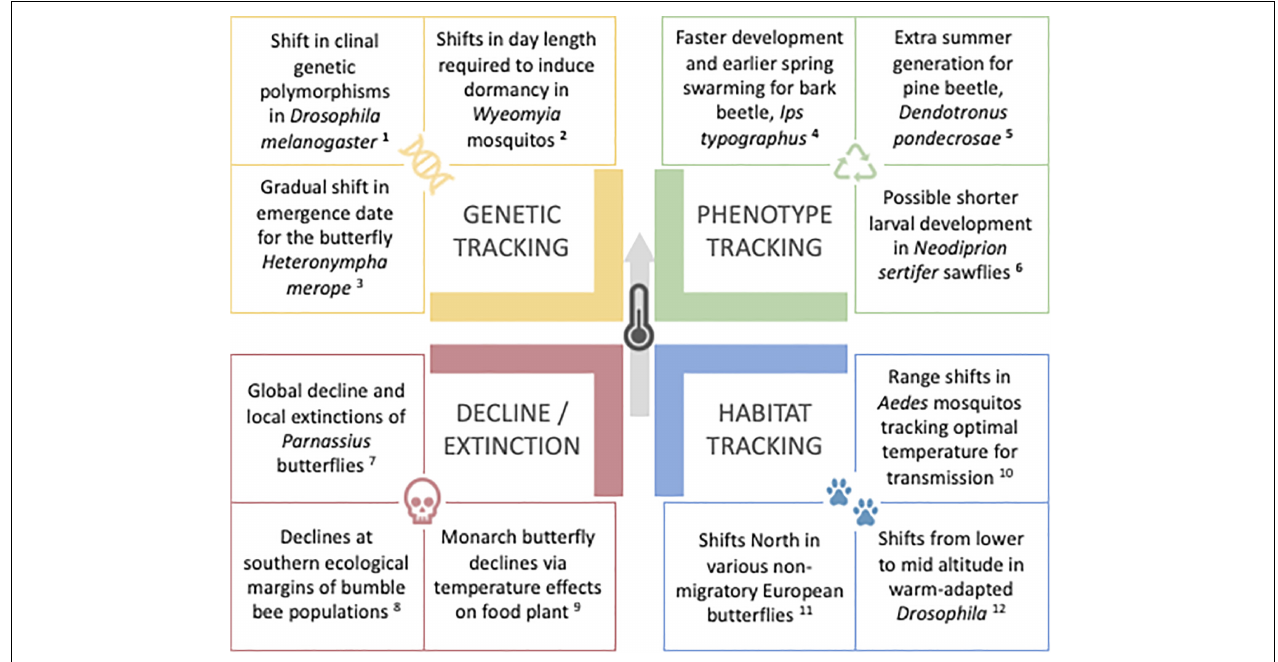
FIGURE 1 | Insect examples of responses to climate change. Populations facing warming temperatures that result from climate change can respond in different manners, including moving to new locations where temperature is closer to their optimum (blue), changing genetic composition as they adapt to new local conditions (yellow), expressing suitable temperature-induced phenotype without genetic change (green), or failing to adjust leading to decline and potential extinction (red). Examples from: 1 Umina et al., 2005; 2 Bradshaw and Holzapfel, 2001; 2001; 3 Kearney et al., 2010; 4 Jönsson et al., 2007; 5 Bentz and Powell, 2014; 6 Kollberg et al., 2013; 7 Condamine and Sperling, 2018; 8 Soroye et al., 2020; 9 Faldyn et al., 2018; 10 Ryan et al., 2019; 11 Parmesan et al., 1999; 12 Parkash et al.,